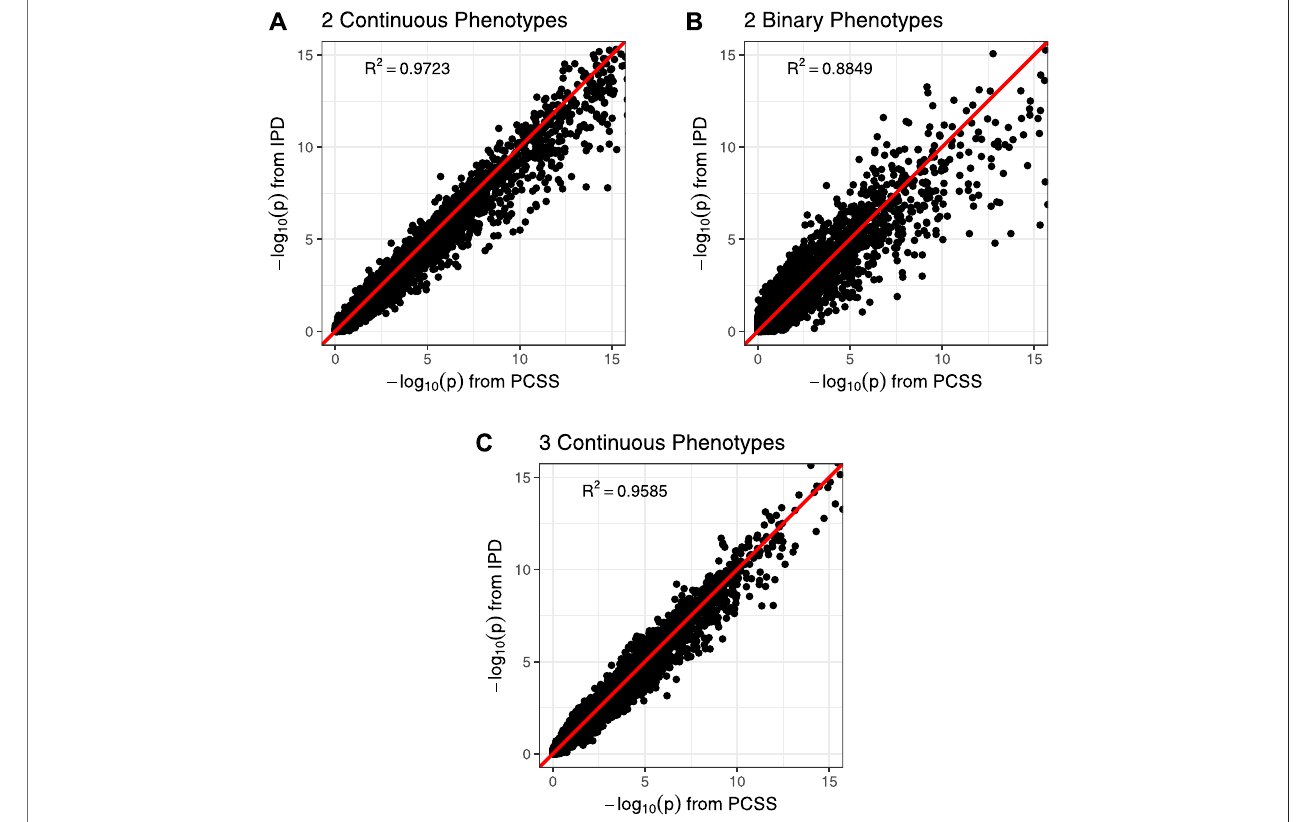
FIGURE 3 | Comparison of p -values from a simulation study approximating a covariate adjusted linear model for a product of phenotypes using pre-computed summary statistics (PCSS) and individual participant data (IPD). Two-sided p -values were computed for the null hypothesis that the SNP had no linear effect on the phenotypeproductwhile adjustingforcovariates. Allplotsarerestrictedtotherange(0,15); unrestricted plotsareavailableinthesupplementarymaterials. (A) Modeling the product of two continuous phenotypes while adjusting for a binary and a continuous covariate. (B) Modeling the product of two binary phenotypes while adjusting for a binary and a continuous covariate. (C) Modeling the product of three continuous phenotypes while adjusting for a binary